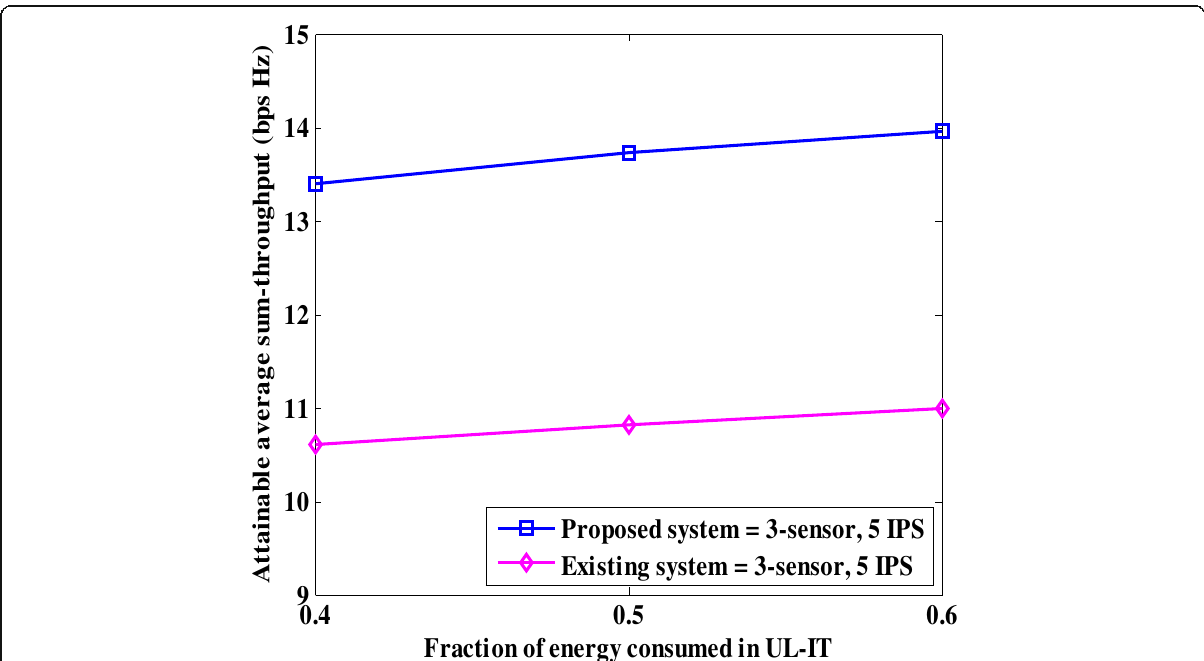
Fig. 11 Attainable average sum-throughput against fraction of energy consumed on information